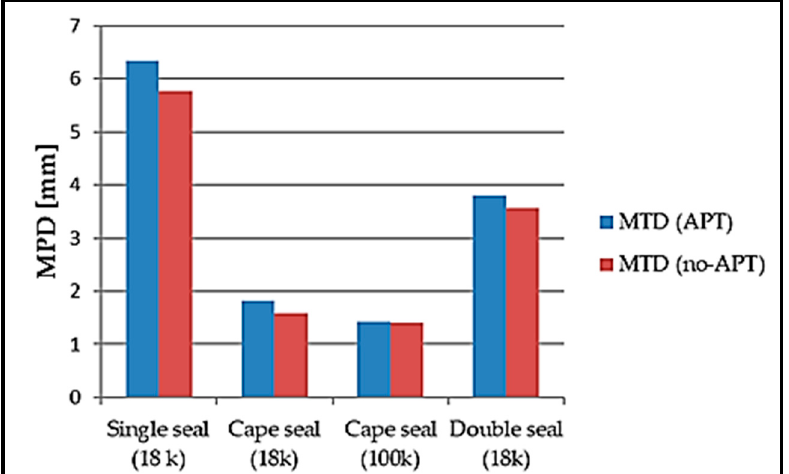
Figure 21. Comparative Mean Profile Depth (MPD) between the various chip seal surfacings both with and without APT loading.